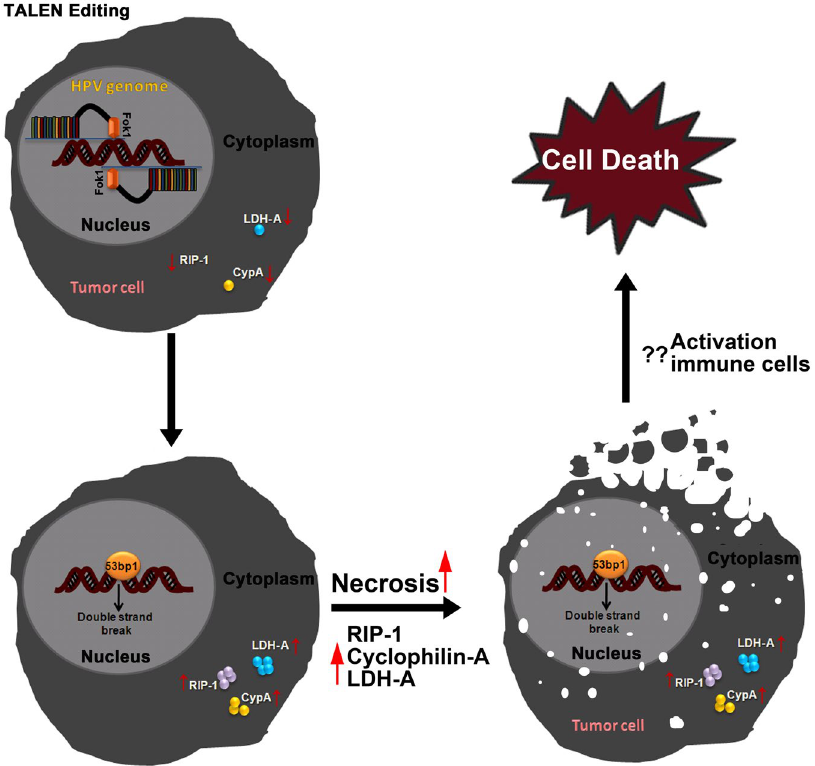
Figure 7. Schematic representation of Necrosis induced by TALEN editing of cervical cancer cells and possible activation of immune cells leading to cell death. When HPV genome integrates in the host genome, it leads to the continuous expression of the two oncogenes E6 and E7. These two oncogenes are responsible for transformation and development of tumor. When TALENs targeting E7 gene is administered ( A ), cells undergo double strand breaks thereby knocking out E7 gene ( B ). Abrogation of E7 gene leads to upregulation of RiP-1, LDH-A, CypA which in turn trigger necrosis ( C ). As an extrapolation of this data, pro-inflammatory cytokines could activate the immune cells and induce cell death. Such a strategy would be useful to induce cell death in cases where tumors acquire resistance to apoptosis through several